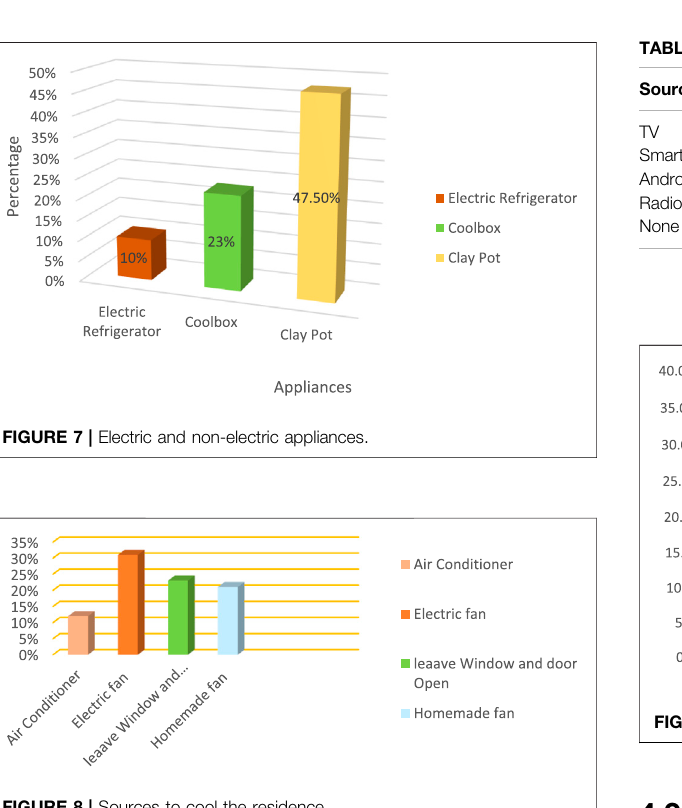
FIGURE 8 | Sources to cool the residence.